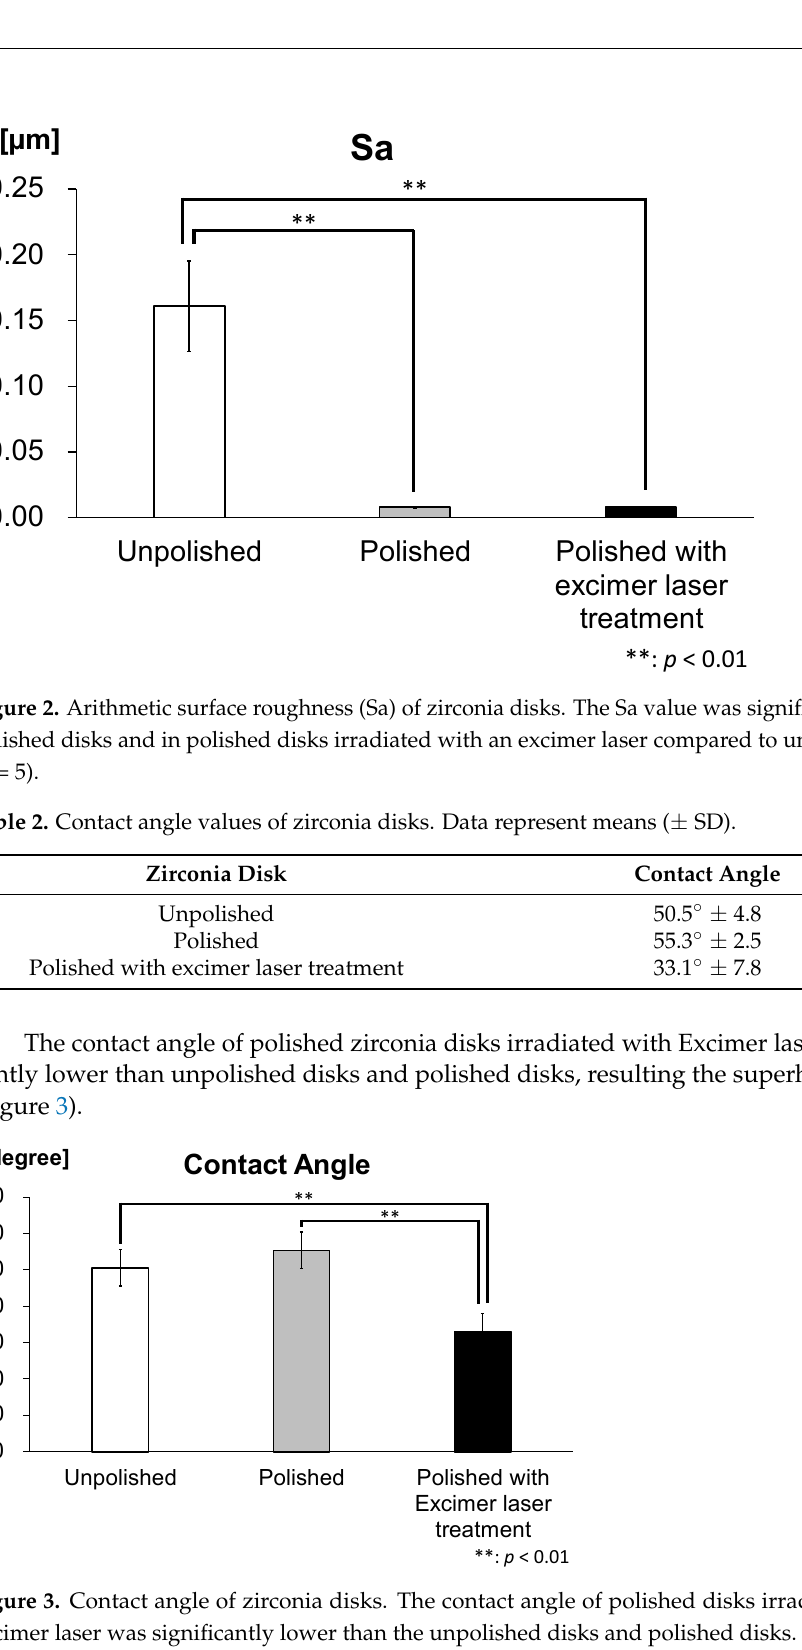
Figure 3. Contact angle of zirconia disks. The contact angle of polished disks irradiated with the excimer laser was significantly lower than the unpolished disks and polished disks. ( n = 5).